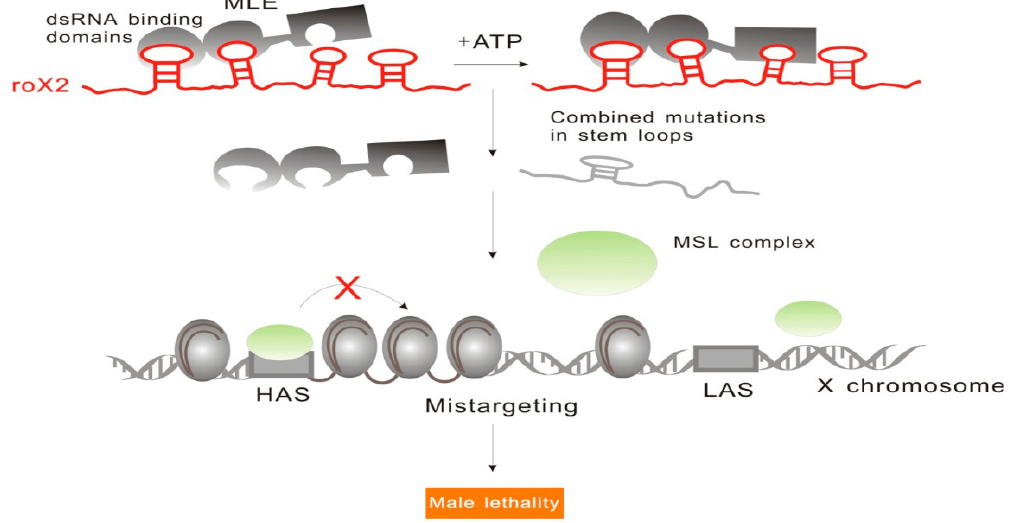
Figure 3. RoX2 tandem stem-loops are involved in MSL complex assembly. RoX2 tandem stem-loops are highly conserved. MLE binding to the different parts of tandem stem-loops has different ATP requirements. MLE binding to the first half of roX2 does not require ATP, while binding to the second half is ATP-dependent. Only when combinatorial mutations occur in stem loops, roX2 is no longer able to recruit MSL, which results in the loss of dosage compensation and male lethality.